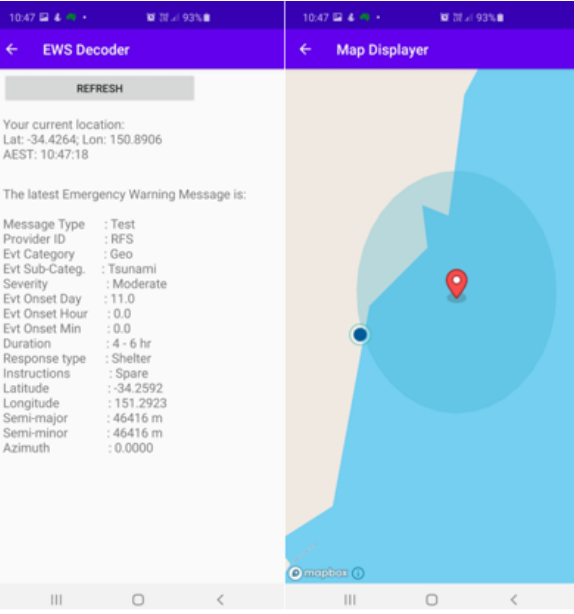
Figure 8. MobileApp screenshots during the Sydney EWS